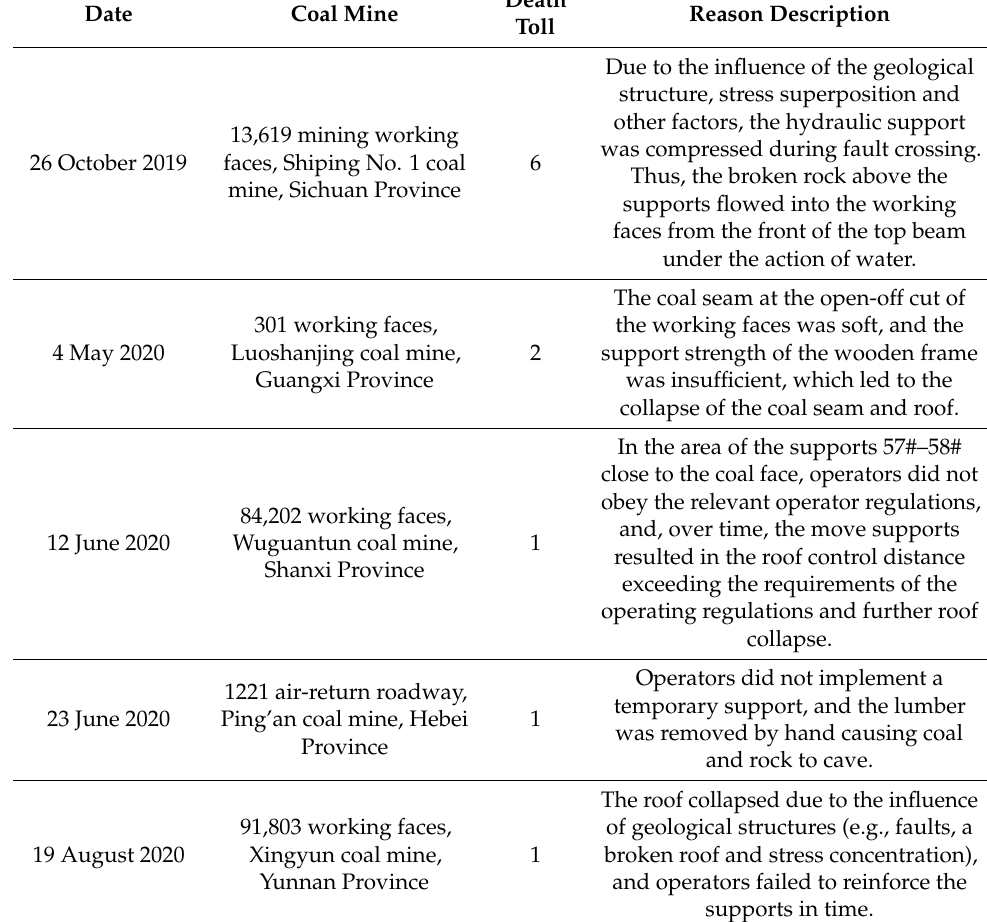
Table 1. Specific conditions of five roof accidents in